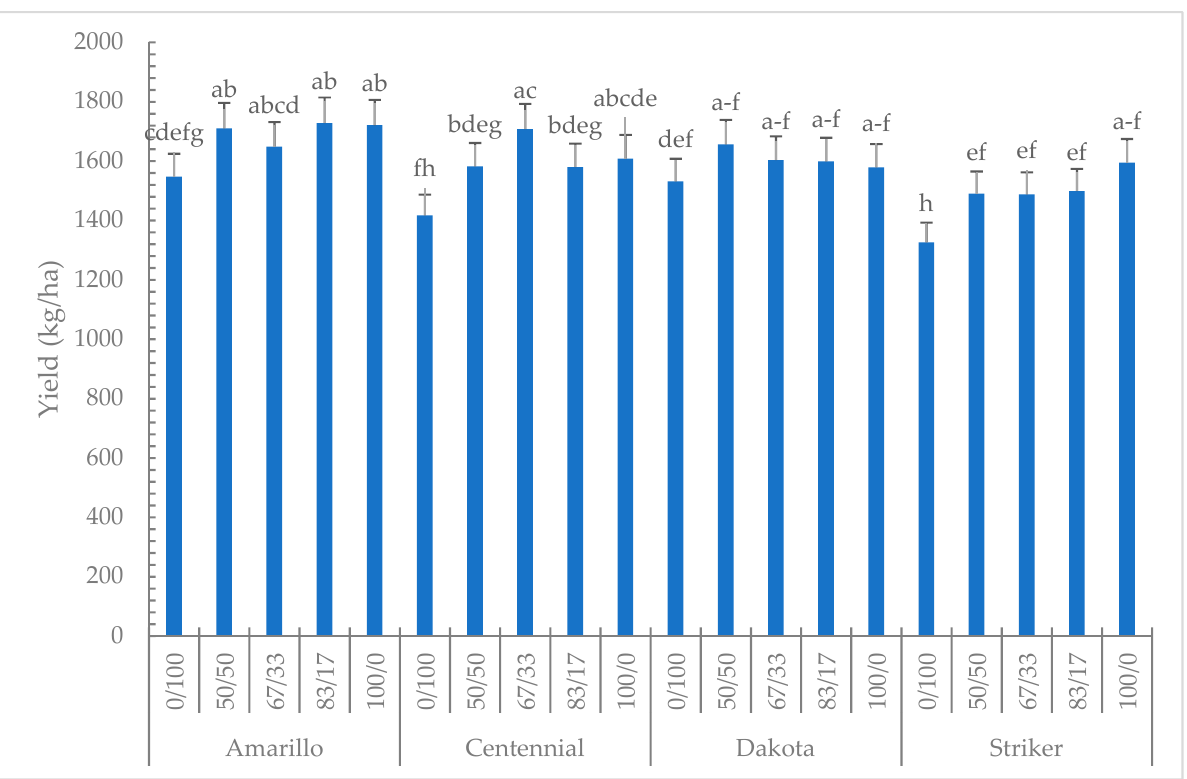
Figure 8. Regression of semi-leafless/leafed ratio on predicted yield based on the combined varieties. Mean of six site-years, one in 2017, two in 2018, and two in 2019.